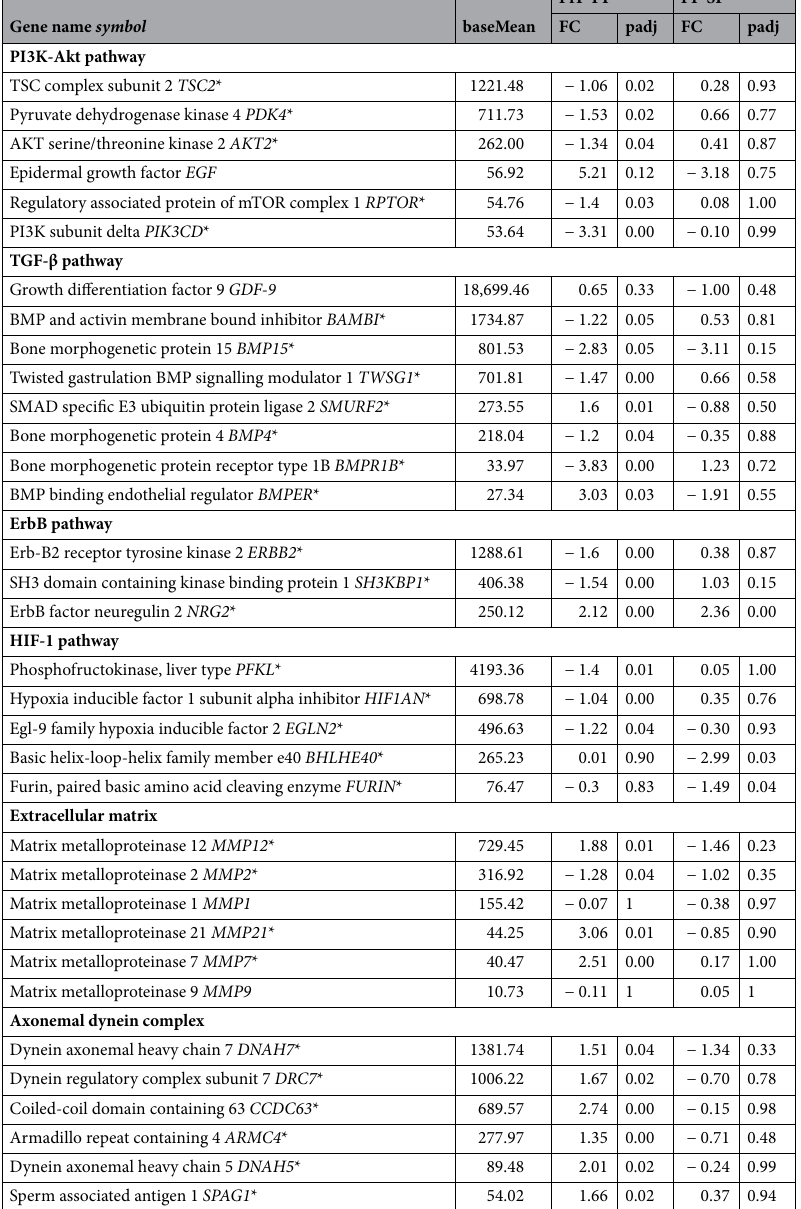
Table 3. Transcript expression DESeq2 data from preantral ovarian follicles in domestic cat (RNA-sequencing data). The transcript expression data was extracted from DESeq2 analysis and were summarised in order of decreasing “baseMean” values. “PI3K-Akt pathway” genes: TSC2 ; PDK4 ; AKT2 ; EGF ; RPTOR ; and PIK3CD . “TGF-β pathway” genes: GDF-9 ; BAMBI ; BMP15 ; TWSG1 ; SMURF2 ; BMP4 ; BMPR1B ; BMPER . “ErbB pathway” genes: ERBB2 , SH3KBP1 , and NRG2 . “HIF-1 pathway” genes: PFKL ; HIF1AN ; EGLN2 ; BHLHE40 ; FURIN . “Extracellular matrix” genes: MMP12 ; MMP2 ; MMP1 ; MMP21 ; MMP7 ; and MMP9. “Axonemal dynein complex” genes: DNAH7 ; DRC7 ; CCDC63 ; ARMC4 ; DNAH5 ; and SPAG1 . “baseMean” is the average of the normalised count values, dividing by size factors, taken over all samples; “FC” fold-change is log2FoldChange, the effect size estimate. This value indicates how much the gene or transcript’s expression seems to have changed between the contrasts reported on a logarithmic scale to base 2; “padj” is the adjusted P value for multiple testing for the gene or transcript; PrF-PF and PF-SF denote primordial versus primary and primary versus secondary DESeq2 contrasts; and * indicates differential gene expression significance with an adjusted P value of < 0.05 and log2 fold-change ≥